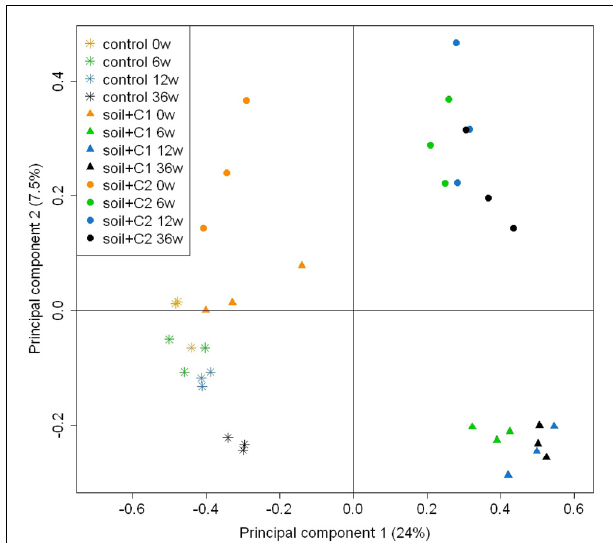
FIGURE 4 | Principle component analysis based on a dissimilarity matrix of OTUs ( > 97% sequence identity) data transformed according to Hellinger (Ramette, 2007). Only OTUs containing > 10 sequences were considered ( n = 3). The number behind the sample name indicates the incubation time in weeks.